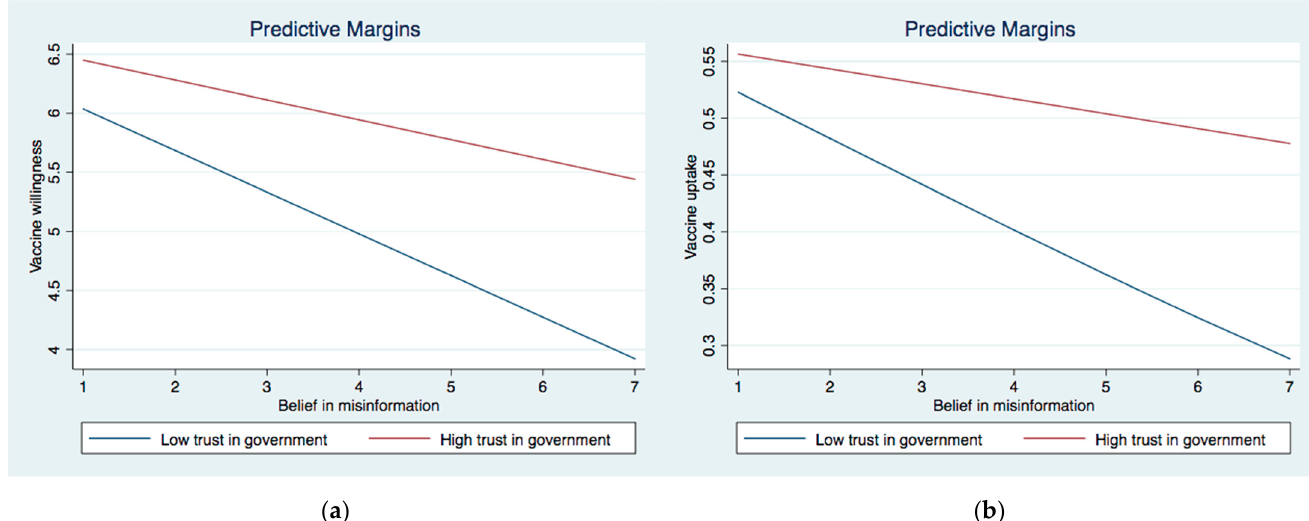
Figure 3. ( a ) Interaction between belief in misinformation and trust in the government on vac- cinewillingness. ( b ) Interaction between belief in misinformation and trust in the government on vaccine uptake.